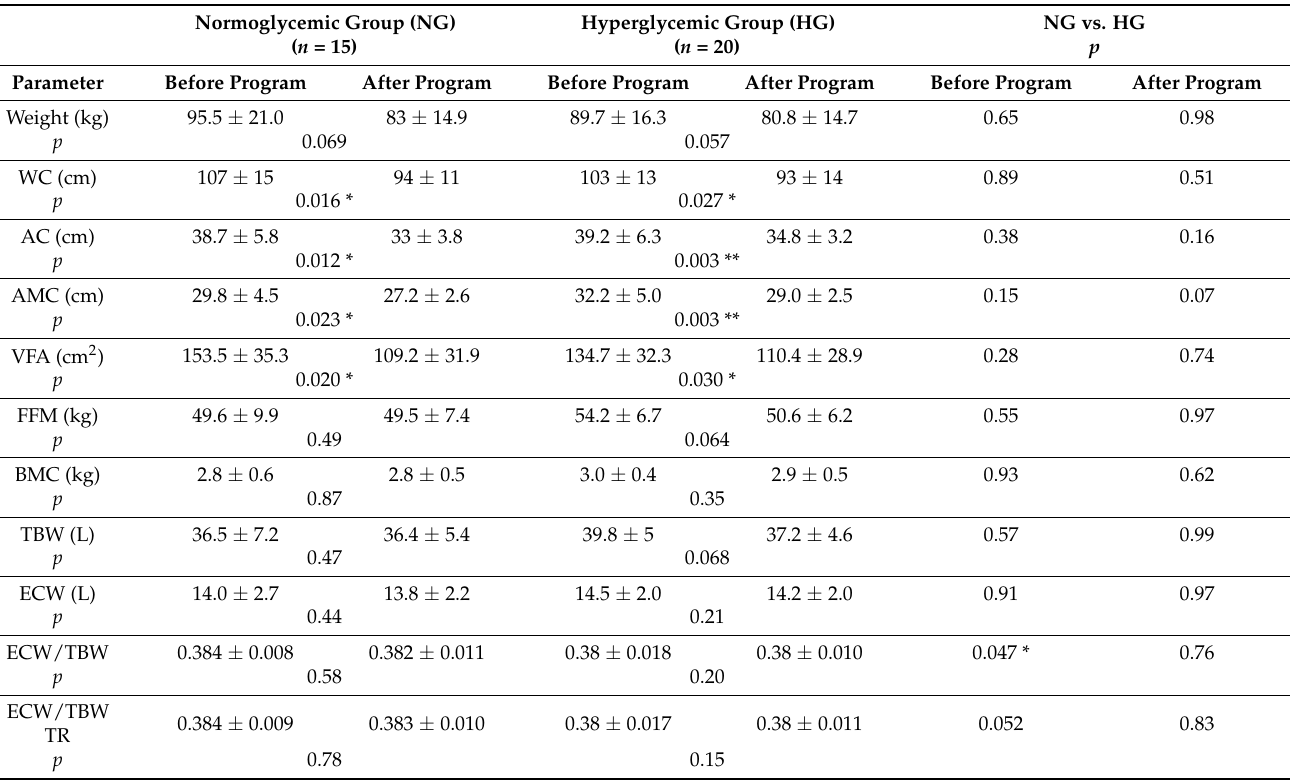
Table 4. Impact of the weight reduction program on selected body composition parameters in obese normoglycemic and hyperglycemic